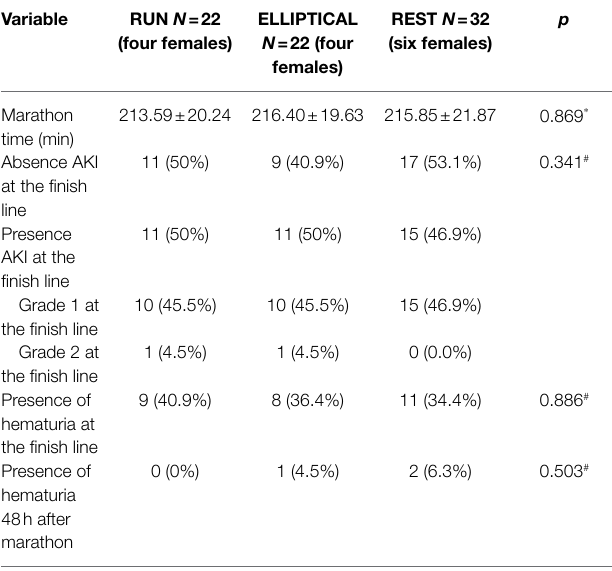
TABLE 2 | Comparison of data collected prior to intervention.